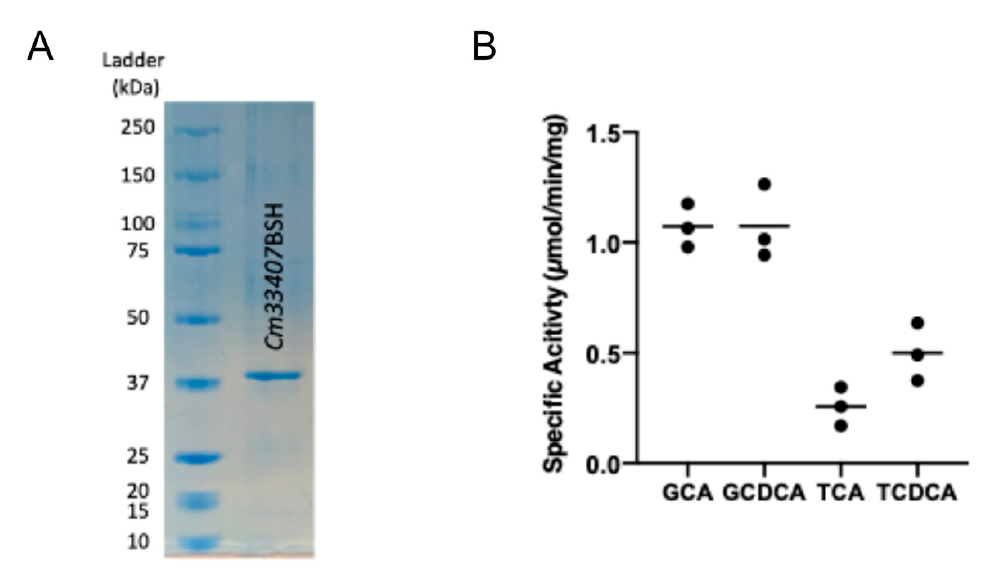
Figure 4. Specific BSH activity of purified Cm 33407BSH. ( A ) SDS–PAGE of